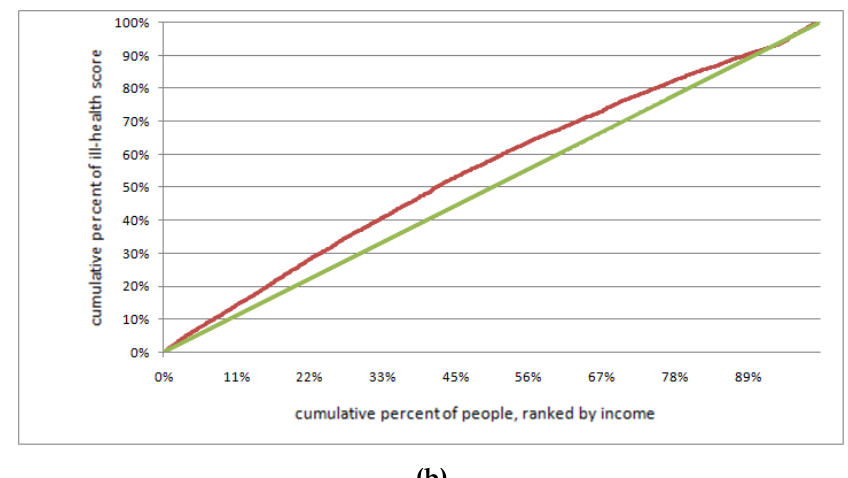
Figure 5. Ill-health concentration curve (red curve) of elderly health by SES difference at the individual level in China. ( a ) Urban vs. rural-related elderly health inequality, CI = 0.3544; ( b ) income-related elderly health inequality, CI = − 0.1428.